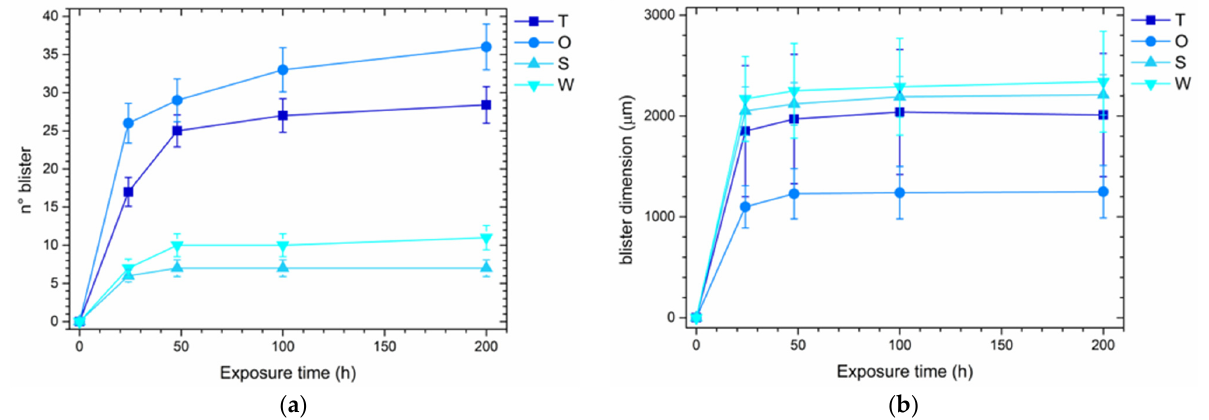
Figure 12. Evolution of ( a ) the number and ( b ) the dimension of blisters developed during UV-B exposure.